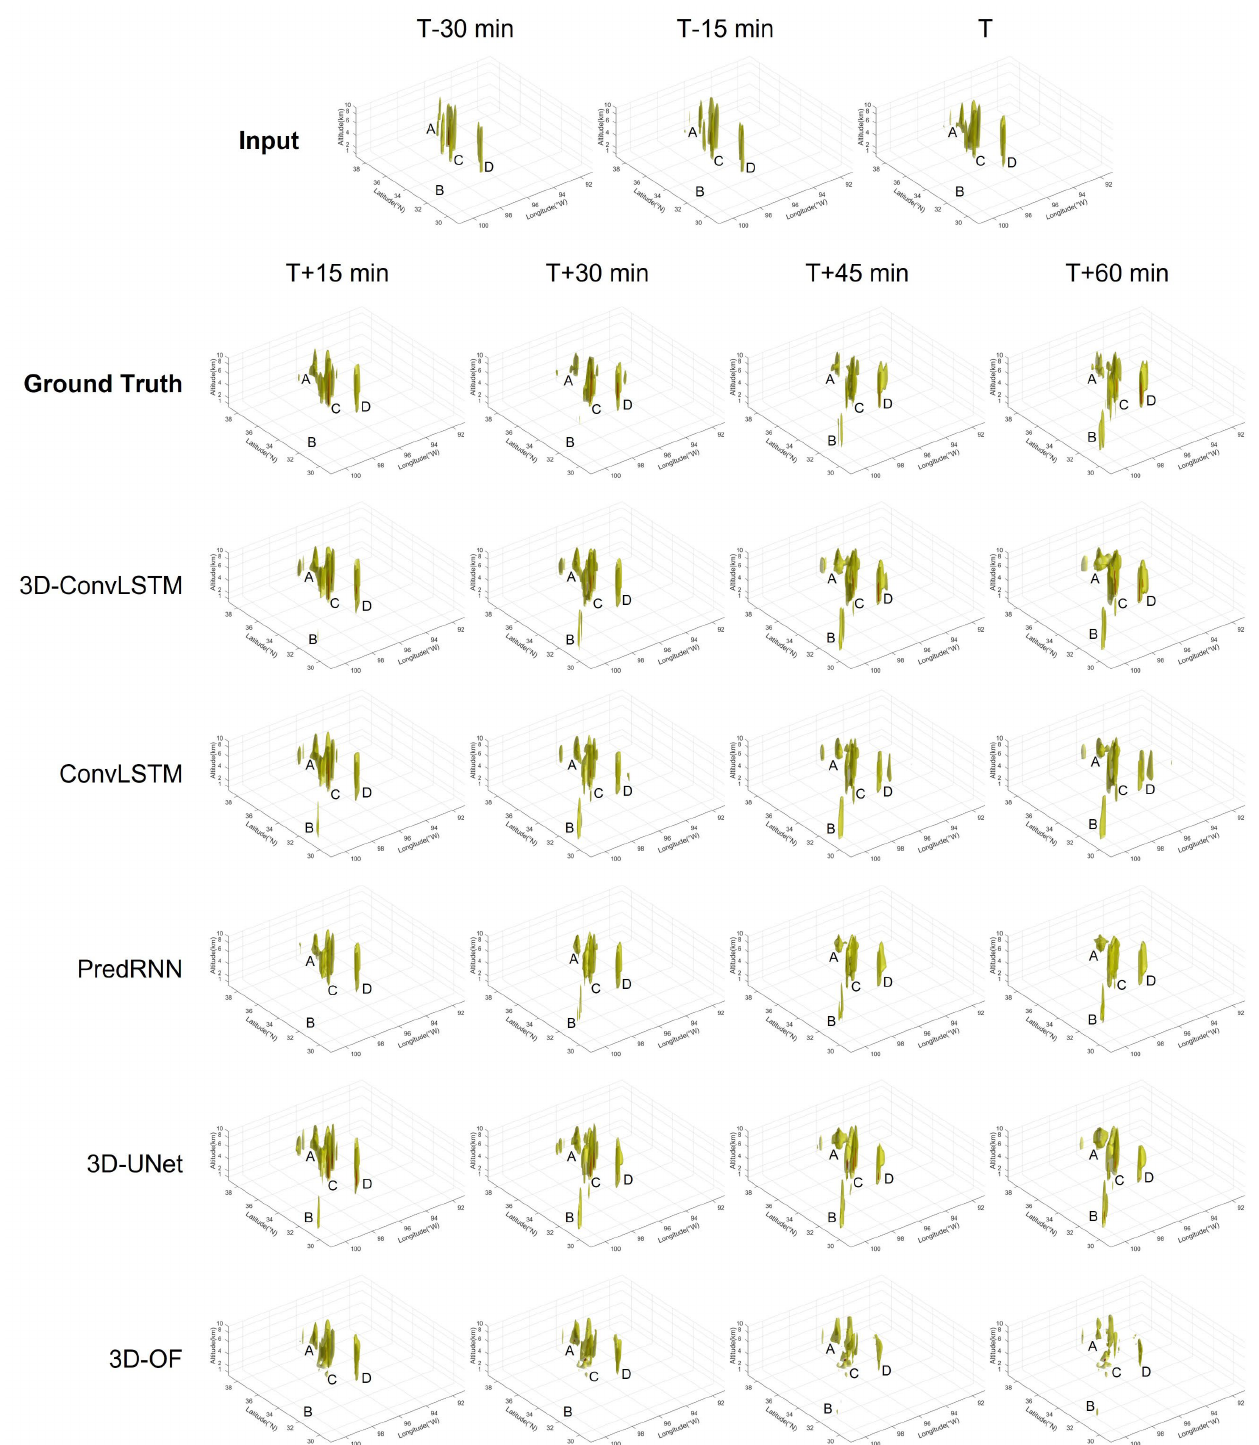
Figure 9. Severe storm event observed at longitudes 100.99–91.01 W and latitudes 29.01–38.99 N in U.S. on 21 October 2019, and its 3D storm nowcasts beginning at time T = 21 October 2019, 03:20 UTC. Storms with reflectivity values greater than 35 and 45 dBZ are shown in yellow and red, respectively. Letters A – D represent different regions where storm evolution occurred.